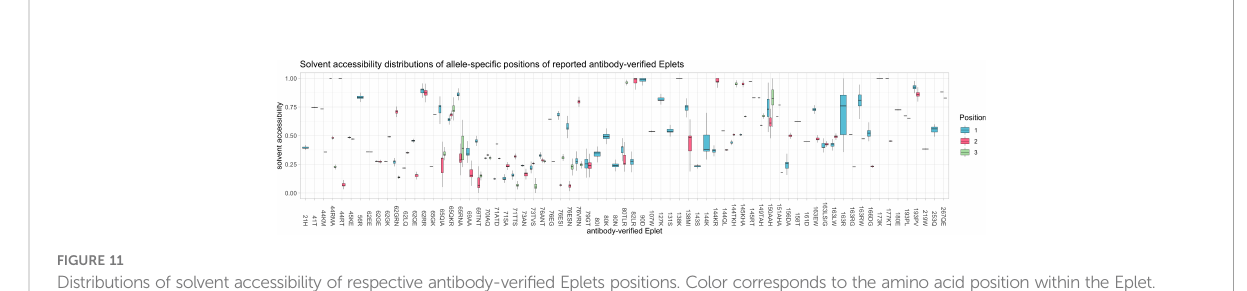
FIGURE 11 Distributions of solvent accessibility of respective antibody-veri fi ed Eplets positions. Color corresponds to the amino acid position within the Eplet. Boxplots depict the median (horizontal line), fi rst to third quartile (box); the highest and lowest values within 1.5× IQR (whiskers),